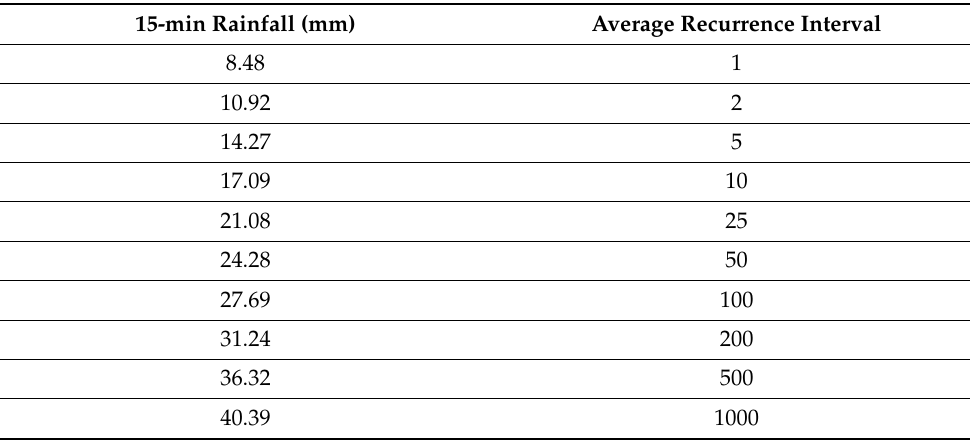
Table 1. 15-min rainfall intensities over watershed M6 and average recurrence intervals. Data derived from the NOAA Atlas 14 Point Precipitation Frequency